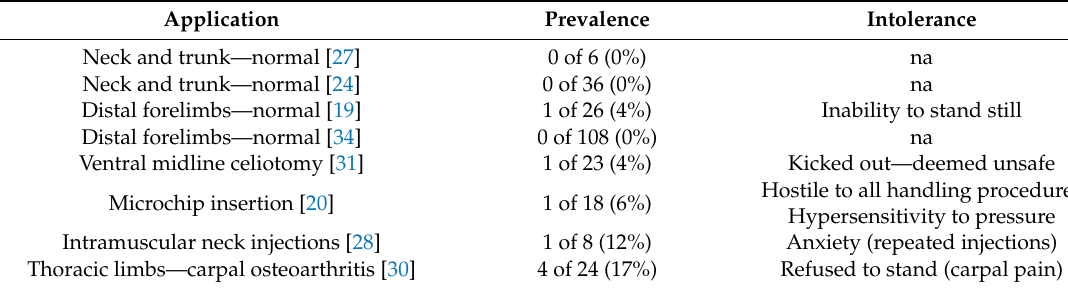
Table 5. Ranked tolerance to applied pressure during MNT procedure.